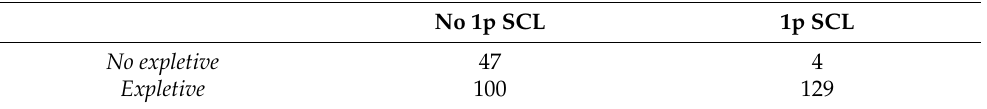
Table 3. The number of dialects exhibiting expletives (with weather verbs) and gaps (in the first person singular). Dataset: Manzini and Savoia (2005) and selected data points from the ASIt database. No 1p SCL 1p SCL No expletive 47 4 Expletive 100 129